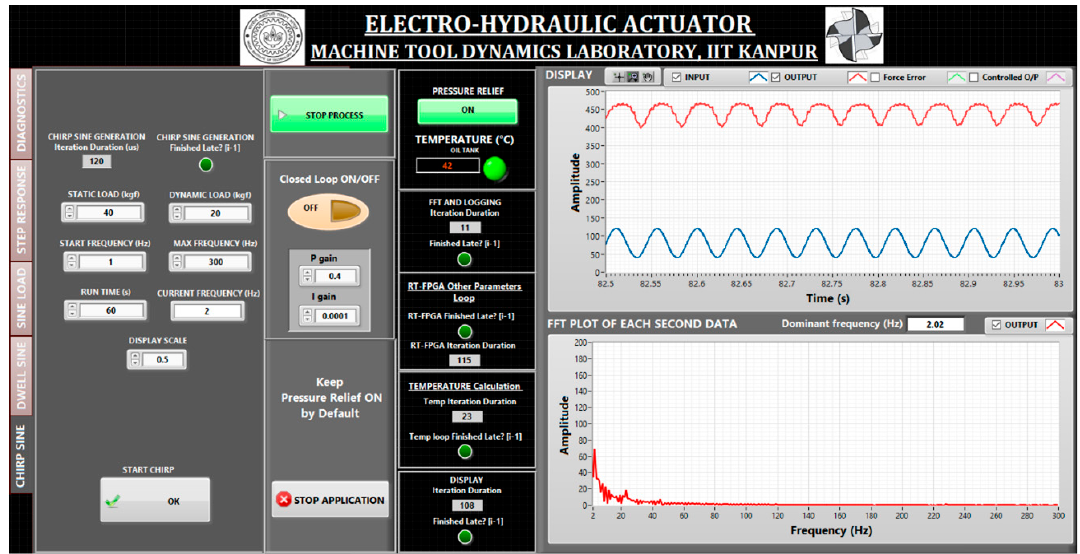
Figure 3. LabVIEW-based graphical user interface (GUI) for the operation of electro-hydraulic actuator.